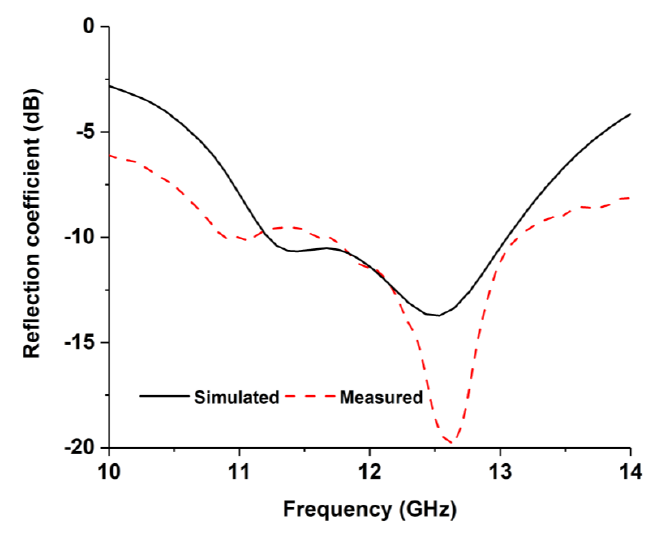
Figure 3. Reflection coefficient results. The simulated 3D radiation pattern of the projected antenna at 12.1 GHz is demon- strated in Figure 4a. The antenna shows 6.53 dBi of realized gain with very low back radia- tion. The substantial decrease in back radiation occurred due to the AMC metamaterial layer. Additionally, the 3 dB simulated axial ratio is also presented in Figure 4b. The antenna shows approximately 165 ◦ of 3 dB axial beamwidth with stable circular polarization.